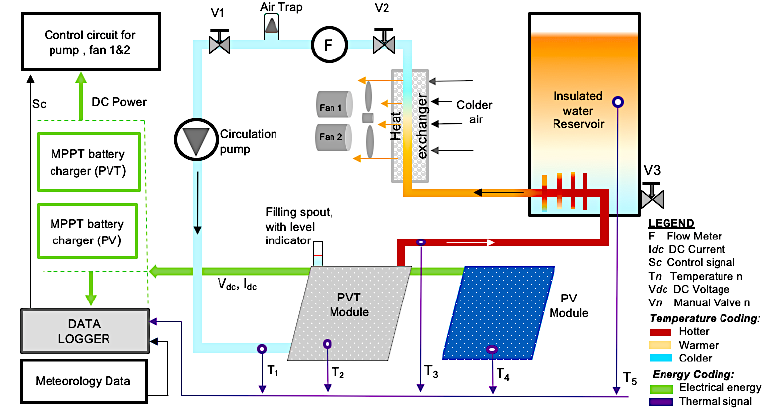
Figure 3. Schematic of the experimental setup.